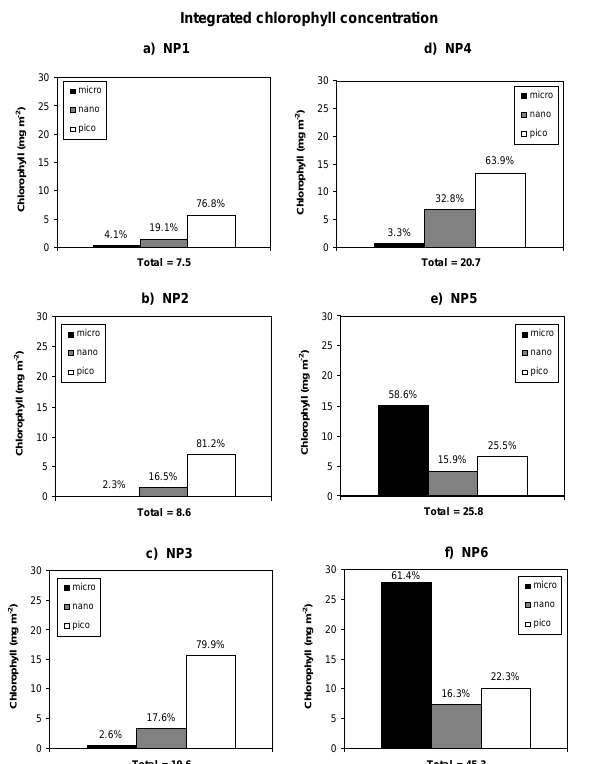
Fig. 8. (a–f) . Euphotic zone (1% for NP1 and NP6, 0.1% for NP2- NP5) integrated measurements of nitrate, ammonium and urea up- Figure 8a-f). Thomalla et al. take (mmolm − 2 d − 1 ) represented as a percentage of total nitrogen uptake for the six productivity stations on the Southbound Transect. Numbers at the top of each bar represent the percent contribution of each nutrient, with total N uptake (NO 3 +NH 4 +urea) at the bottom of each figure.